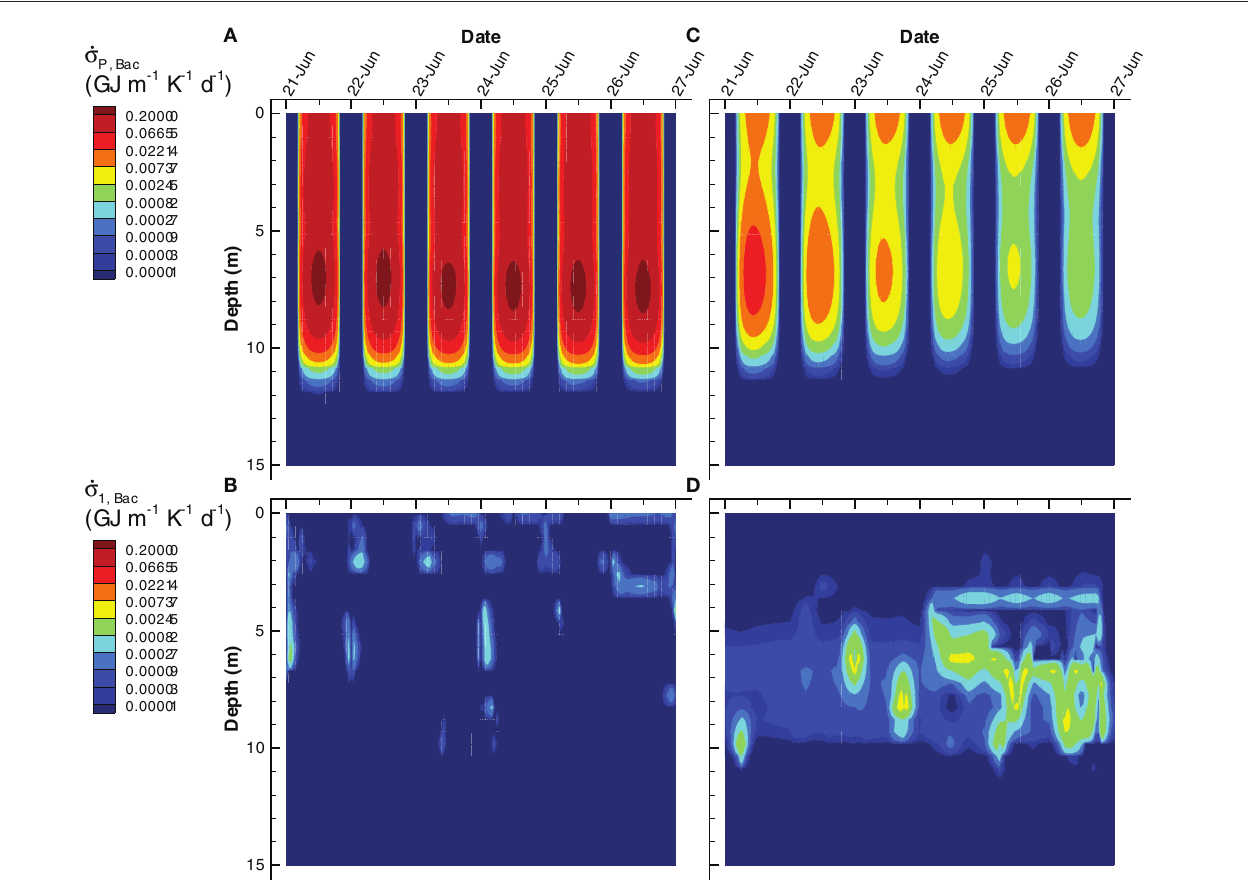
FIGURE 12 | Contour plots of entropy production by bacteria associated with light absorption by bacterial biomass, ˙ σ P , Bac (A,C) and growth of bacteria, r 1, Bac , on organic carbon, ˙ σ 1, Bac , Equation (S94) (B,D) for the SIO (A,B) and LIO (C,D) simulations.